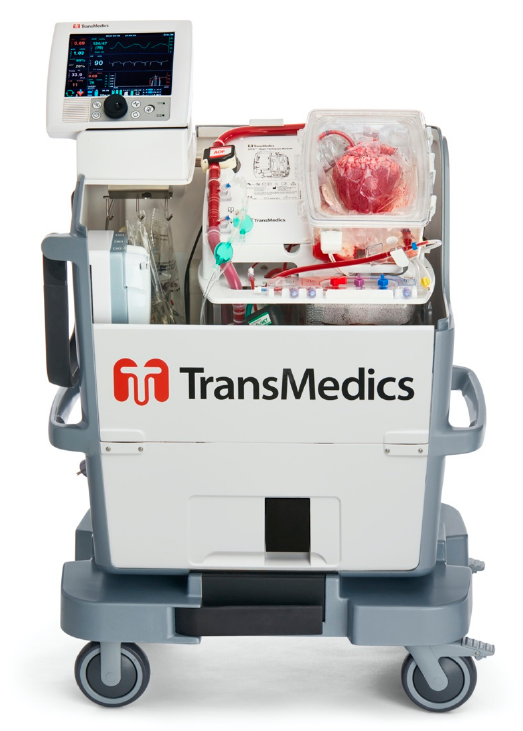
Figure 2. Transmedics Organ Care System. Normorthermic, continuous perfusion is established via the aortic root. The heart is maintained in sinus rhythm during transport. Photograph used with permission from Transmedics Inc. permission from Transmedics